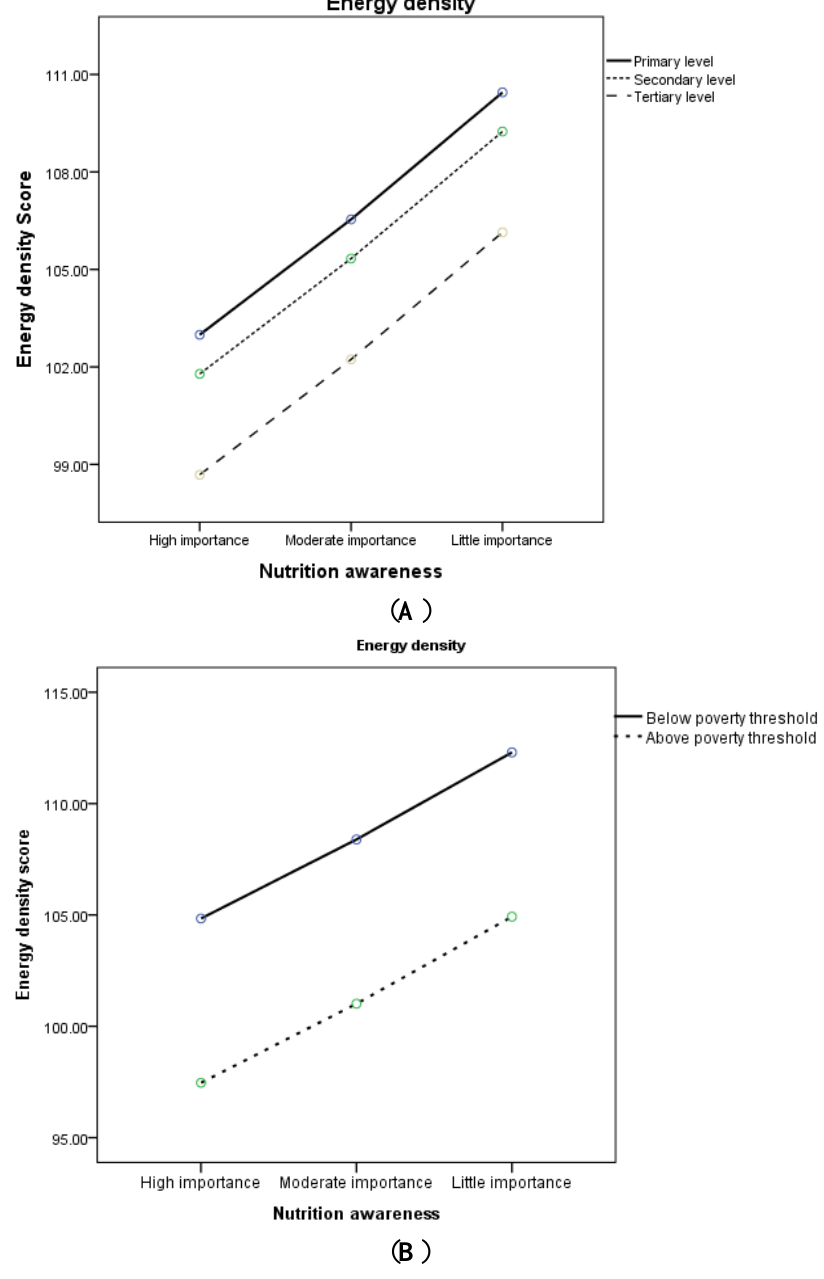
Figure 1. Covariate-adjusted mean * of dietary energy density score across levels of nutritional awareness by ( A ) education level (* adjusted for age, sex, country of birth, BMI, and income); ( B ) household poverty threshold (* adjusted for age, sex, country of birth, BMI, and education